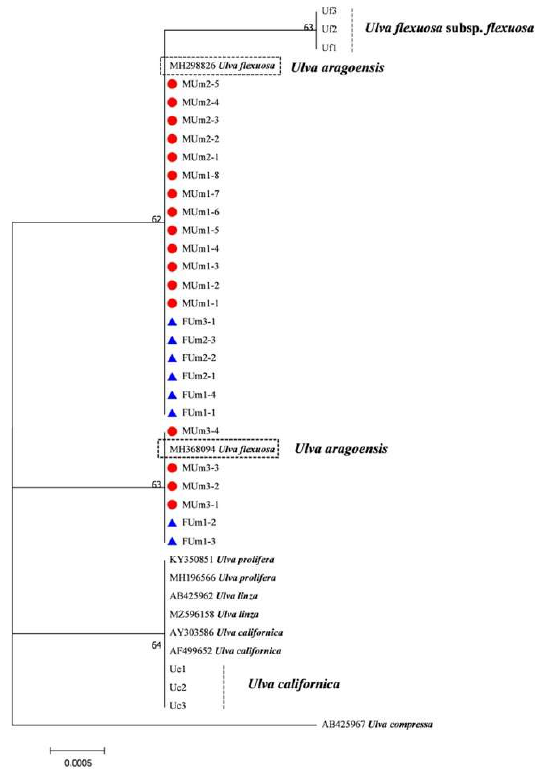
Figure 9. Maximum likelihood tree constructed from the analysis of 18S gene sequences of U. aragoensis samples and those downloaded from GenBank.